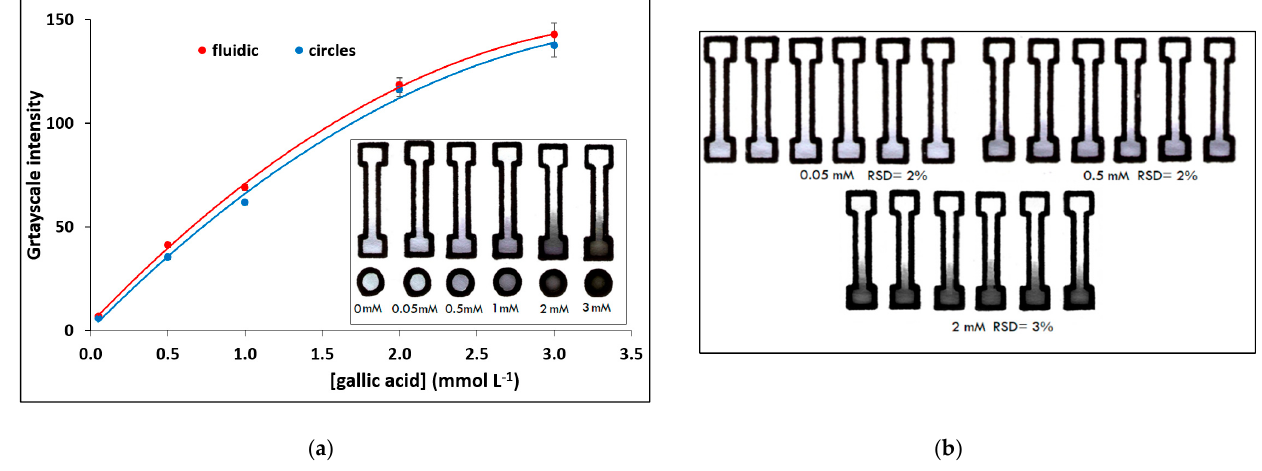
Figure 3. Assay of total phenols using gallic acid as standard: ( a ) calibration plot and photos of the assay at different gallic acid concentrations of fluidic and circular PADs, ( b ) photos illustrating between-device reproducibility at 3 concentration levels (pen No 17; paper 7; single-sided plotting; 2 passes; pen plotting speed 2.7 cm − 1 ).